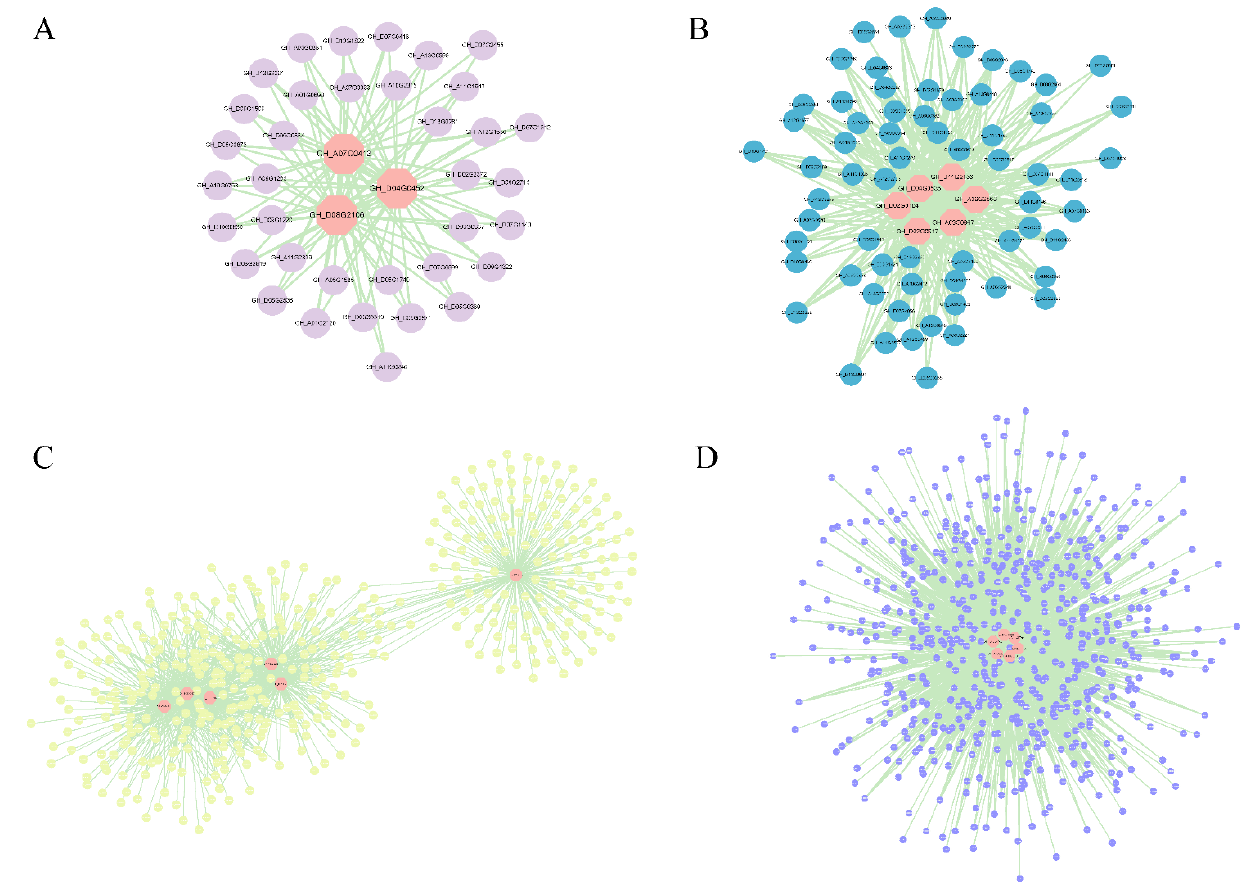
Figure 7. Coexpression network analysis of the ( A ) magenta module, ( B ) black module, ( C ) brown module, and ( D ) blue module. The central hub gene is represented by an orange circle. Table 2. Hub genes and annotations.